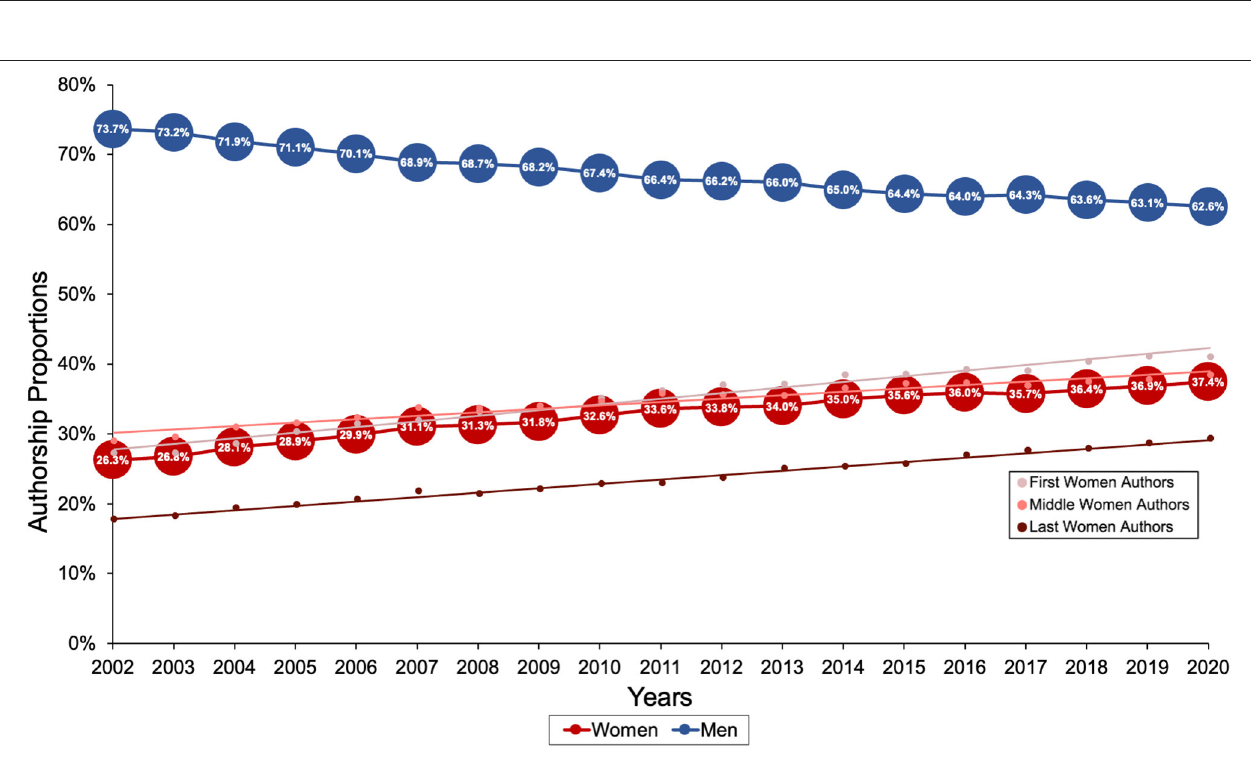
FIGURE 3 | Gender authorship proportion from 2002 up to